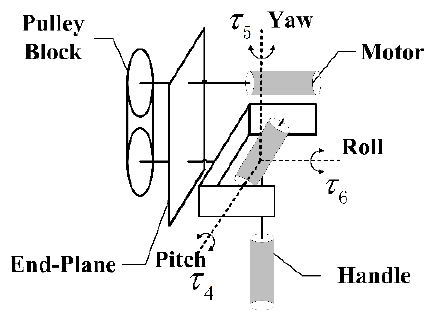
Figure 5. Rotating mechanical structure.